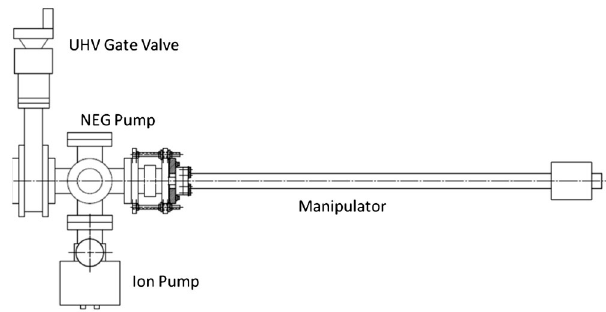
FIG. 3. Schematic of the vacuum suitcase composed of a magnetic sample manipulator, six-way cross with 4.5’’ CF, gate valve, and vacuum pumps.